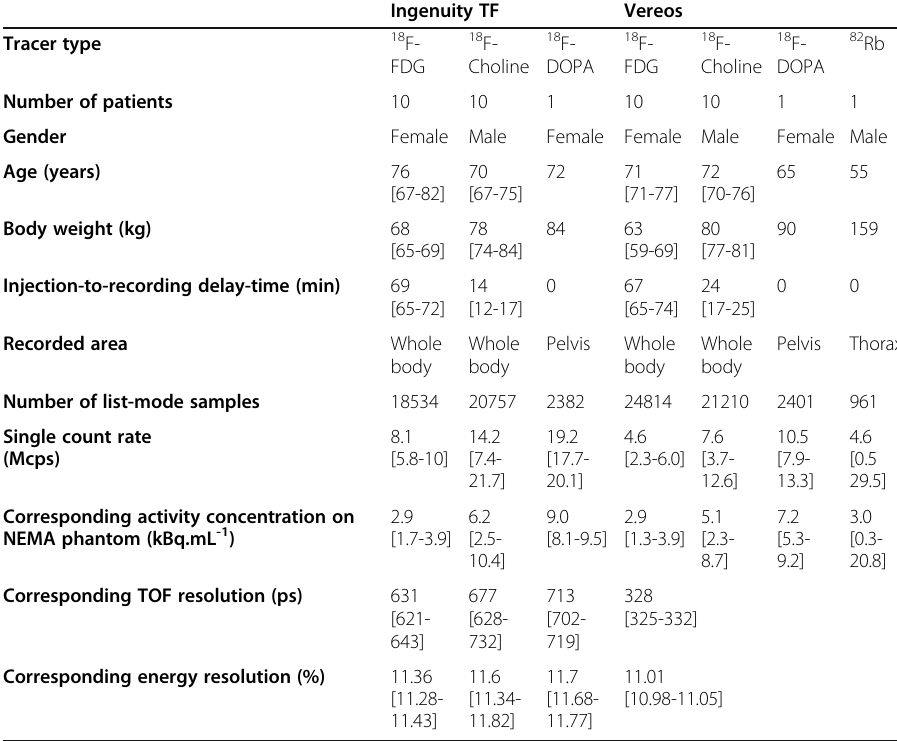
Table 2 General patient characteristics and main PET parameters recorded or computed in the different groups imaged in clinical routine with the Vereos (digital-PET) or Ingenuity (analog-PET) camera and after the injection of 3 MBq.kg -1 of current 18 F-labeled tracers, with an additional patient imaged after the injection of 7 MBq.kg -1 of 82 Rb on the Vereos camera. Continuous variables are presented with median values [minimum – maximum values after exclusion of outliers] Ingenuity TF Vereos